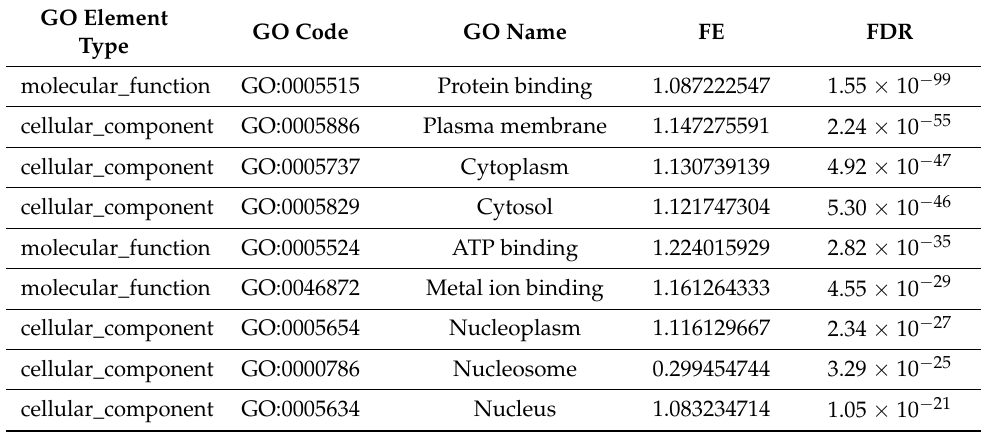
Table 2. Enrichment Analysis for Cluster